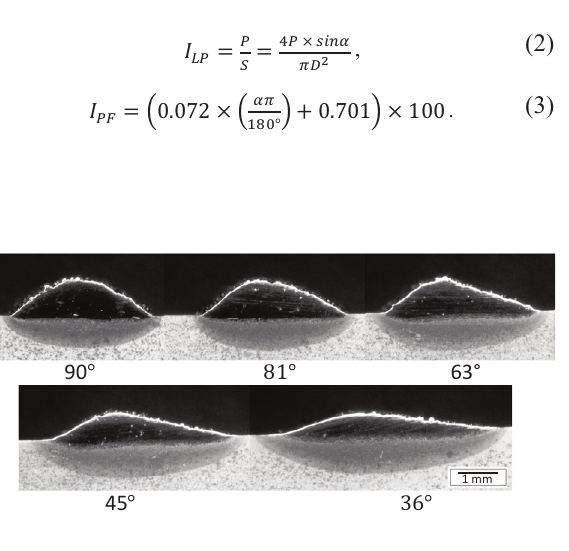
Fig. 3. Hardness measuring scheme: 1 – vertical; 2 – horizontal " over the cladding. Fig. 4. The influence of on the shape of the cladding